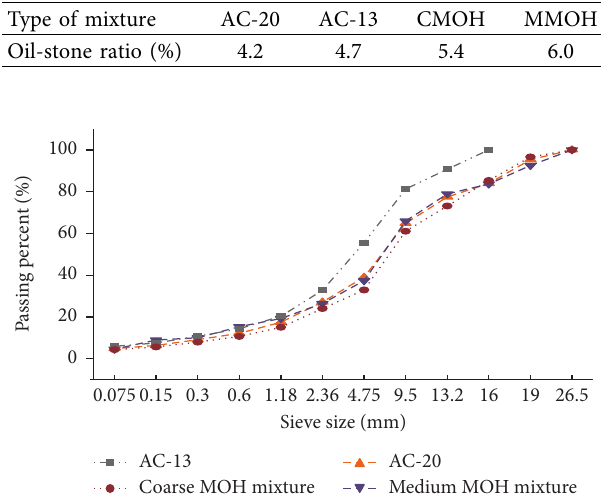
Figure 10: Gradation of each type of mixture. Table 4: Properties of the raw